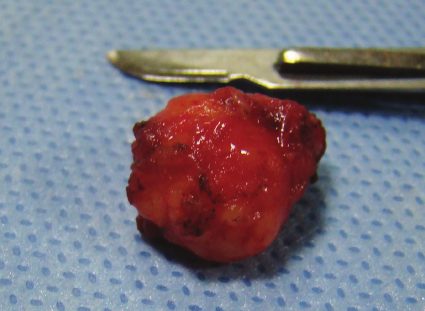
Figure 1: Intraoral swelling in relation to 34, 35 region.